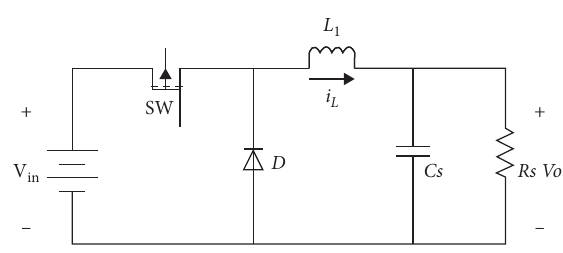
Figure 2: Equivalent Buck converter of the variable structure